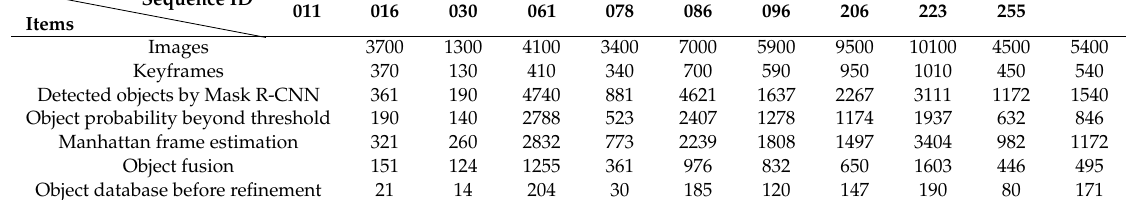
Table 4. Details of experiments on 10 sequences of SceneNN dataset.